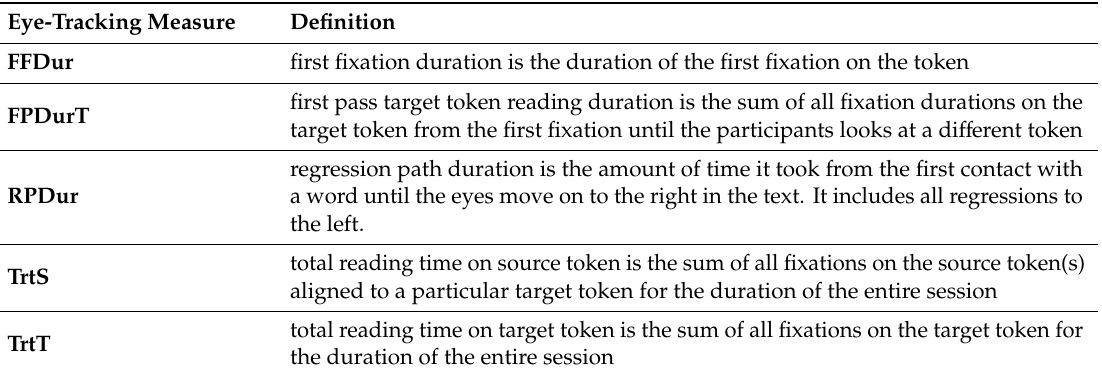
Table 4. The eye-tracking measures used as dependent variables in the regression models. Eye-Tracking